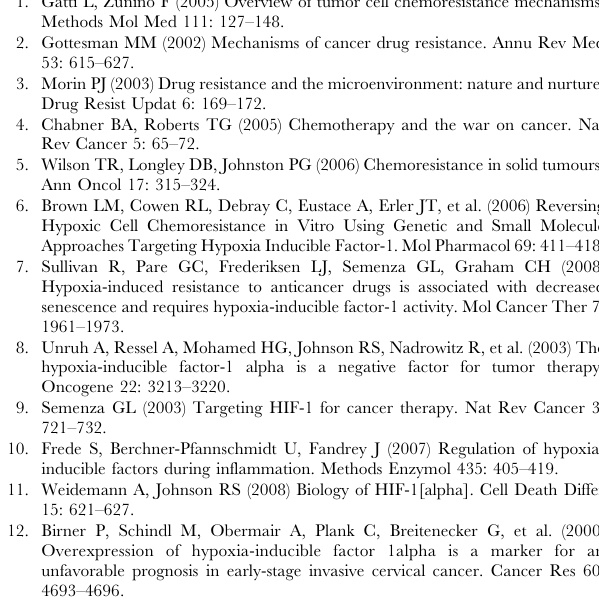
Figure S1 HIF-1 a mediates resistance towards the chemother- apeutic agent cisplatin in AGS cells. Proliferation of AGS KD and SCR cells 48 h after treatment with increasing concentrations of cisplatin under normoxic conditions (**, P , 0.01). Values represent the mean 6 SEM of triplicate determinations and cell numbers are shown as percent of untreated cells. Figure S2 HIF-1 a mediates resistance towards the chemother- apeutic agent 5-FU under hypoxic conditions. Proliferation of AGS KD and SCR cells 24 h after treatment with increasing concentrations of 5-FU under hypoxic conditions (**, P , 0.01; ***, P , 0.001). Values represent the mean 6 SEM of triplicate determinations and cell numbers are shown as percent of untreated cells. Figure S3 Restoration of wild-type p53 by PRIMA-1 in MKN28 cells with mutant p53. MKN28 KD and SCR cells were pretreated with 30 m mol/L PRIMA-1 for 6 h and then exposed to 10 m g/ml 5-FU. Cell growth was determined 24 h after treatment with 5-FU (**, P , 0.01). Values represent the mean 6 SEM of triplicate determinations and cell numbers are shown as percent of untreated cells.